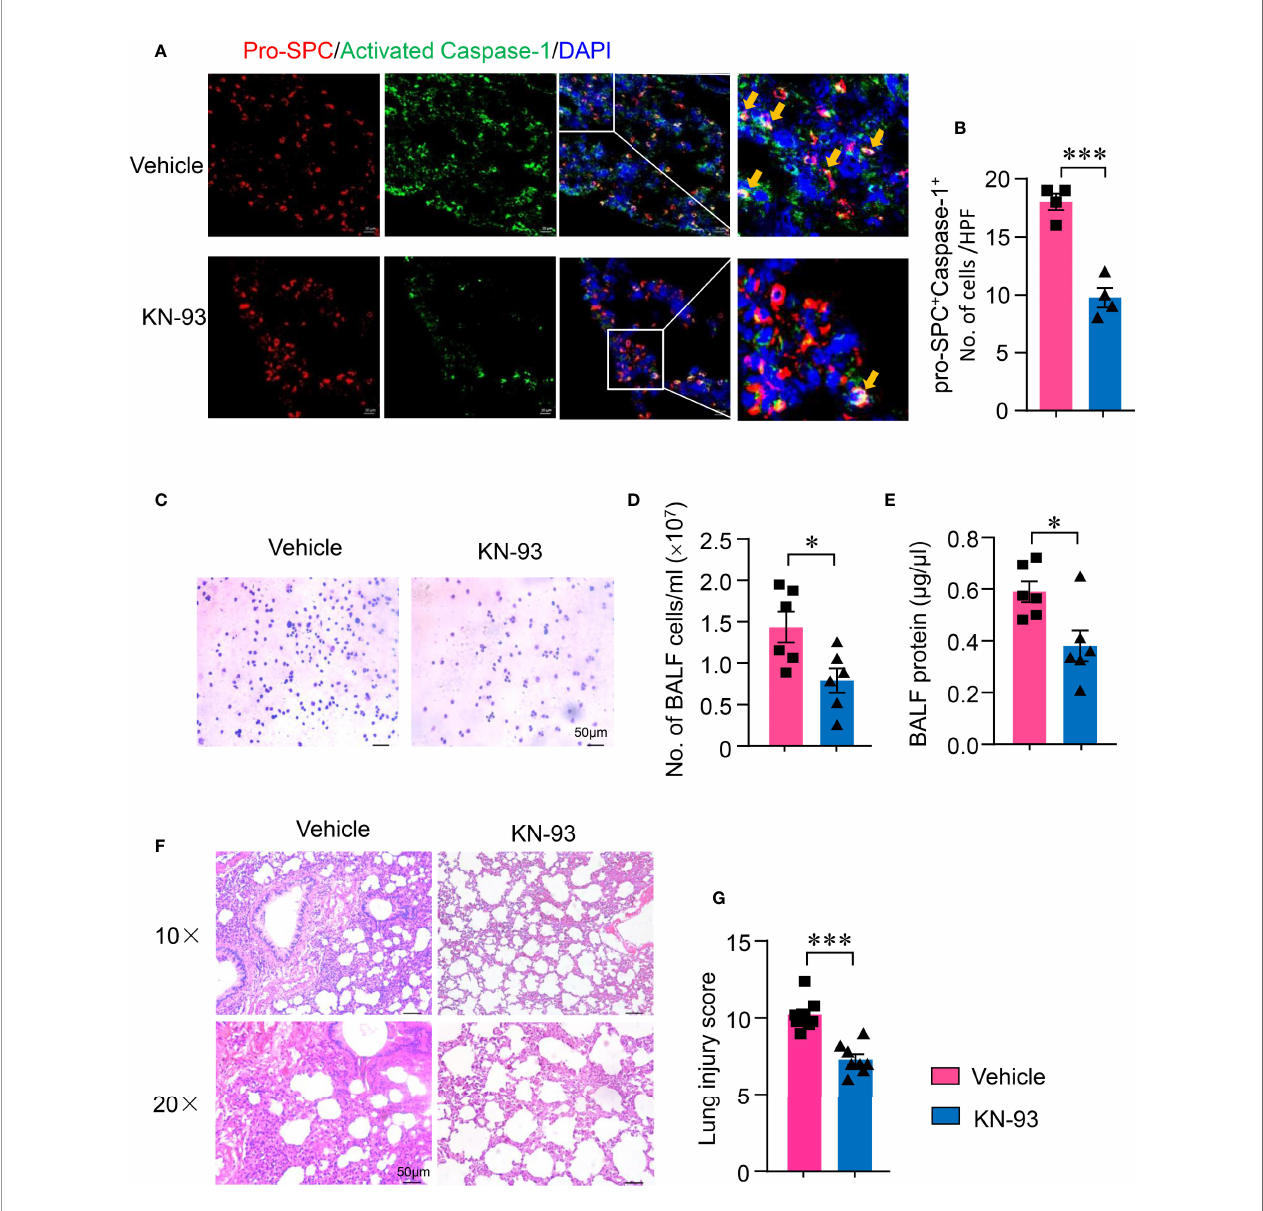
FIGURE 6 | KN-93 inhibited NLRP3 activation in type II alveolar epithelial cells and ameliorated acute lung injury. Sections from lung tissues of ALI mice treated with KN-93 or vehicle were stained with Alexa Fluor A555-conjugated anti-pro-SPC and FAM-FLICA. (A) Representative images showing pro-SPC (red) and activated Caspase-1 (green) expression in lung tissues. Scale bar: 20 m m. (B) The number of pro-SPC + FLICA + cells per high power fi eld in the lung tissues were summarized from 4 mice. (C) Cytospin cells were collected from bronchoalveolar lavage fl uid (BALF) and Wright-Gimsa staining was performed. Representative images were shown. Scale bar: 50 m m. (D) Total cell counts in BALF from KN-93 or vehicle treated mice. (E) Protein concentration in BALF was measured using a BCA assay. (F, G) HE staining of lung sections from KN-93 or vehicle treatment ALI mice. Representative images. Scale bar: 50 m m. Lung injury score was calculated and summarized from 8 mice. All data are mean± SEM. *p < 0.05, ***p <